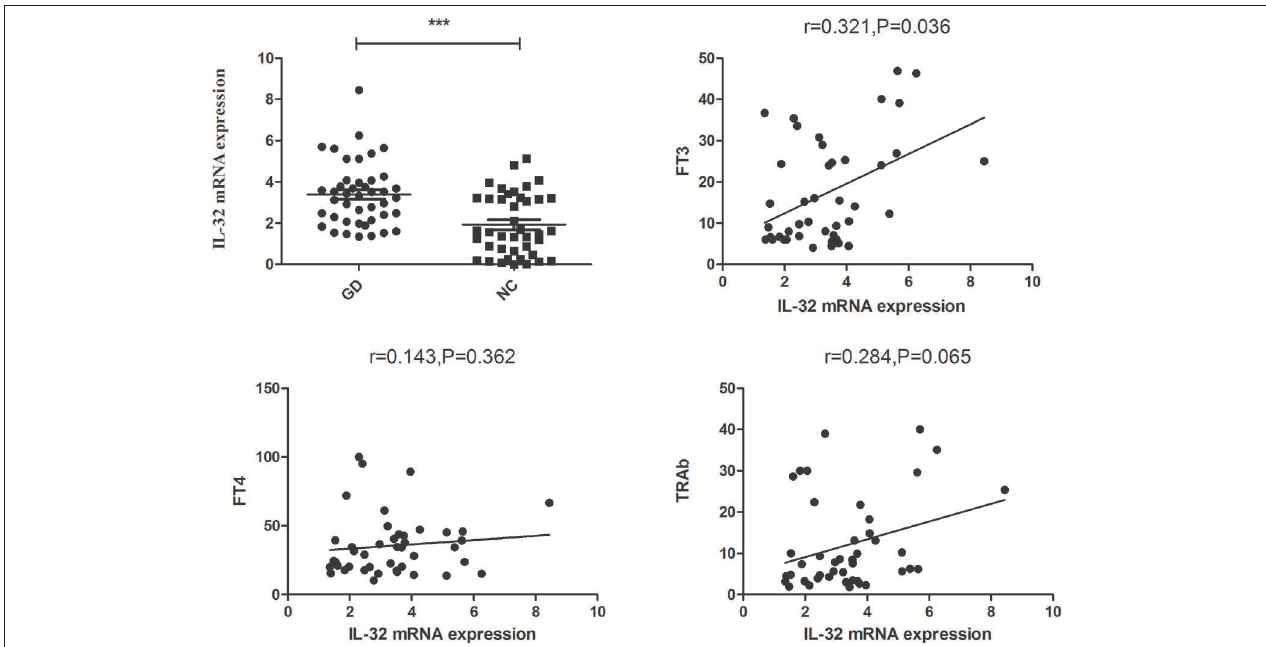
FIGURE 1 | The expression of IL-32 mRNA in GD patients. IL-32 mRNA expression in GD patients was significantly higher than that in controls; IL-32 mRNA expression in GD patients was positively correlated FT3. NC, normal controls. *** P < 0.001.